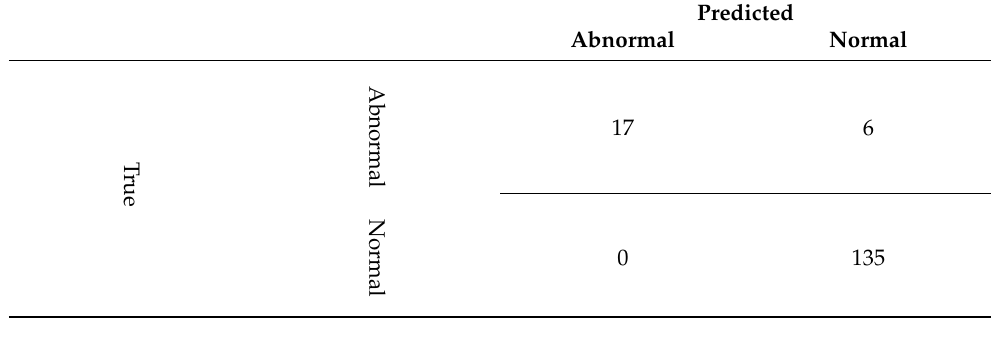
Figure 5. True label and assessment result of the model in which the number of mixture components K was determined based on BIC ( K = 29, threshold is 99th percentile’s value): ( a ) wind speed- rotational speed characteristic with true label; ( b ) time characteristics of rotational speed with true label; ( c ) wind speed rotational speed characteristic with predicted label; ( d ) time characteristics of